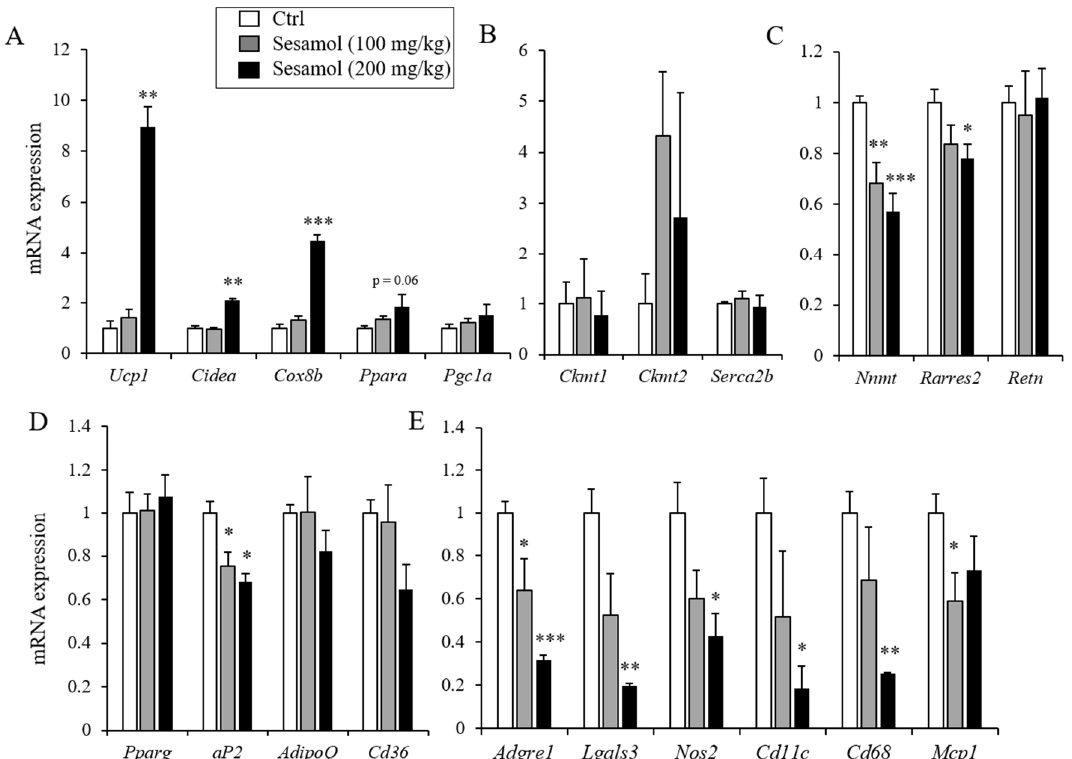
Figure 5. Oral administration of sesamol selectively increases thermogenic markers in white adipose tissue. Gene expression was measured from inguinal white adipose tissue (iWAT) isolated from mice fed with a high-fat diet and orally treated with the vehicle control or sesamol (100 mg/kg and 200 mg/kg per day) ( n = 5 per group). ( A ) mRNA expression of the thermogenic adipocyte selective genes ( Ucp1 , Cidea, Cox8b, Ppara and Pgc1a ), ( B ) Ucp1-independent thermogenic genes ( Ckmt1 , Ckmt2 , and Serca2b ), ( C ) white adipocyte selective genes ( Nnmt, Rarres2, and Retn ), ( D ) pan-adipocyte genes ( Pparg , aP2 , AdipoQ , Cd36 ), and ( E ) inflammatory markers ( Adgre1 , Lgals3 , Nos2 , Cd11c , Cd68 , and Mcp1 ) were measured in inguinal adipose tissue by real-time PCR. Data represent means ± s.e.m. Statistically significant differences in the gene expression between the control- ( n = 5) and sesamol-treated mice ( n = 5) were determined by Student’s t -test (* p < 0.05; ** p < 0.005; *** p < 0.0005).